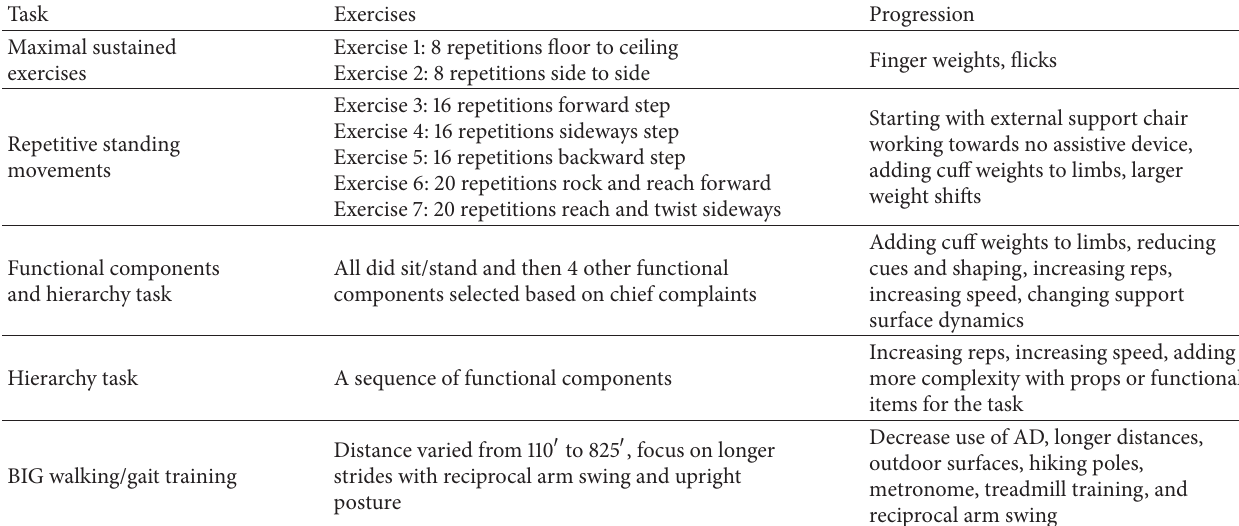
Table 6: LSVT BIG interventions